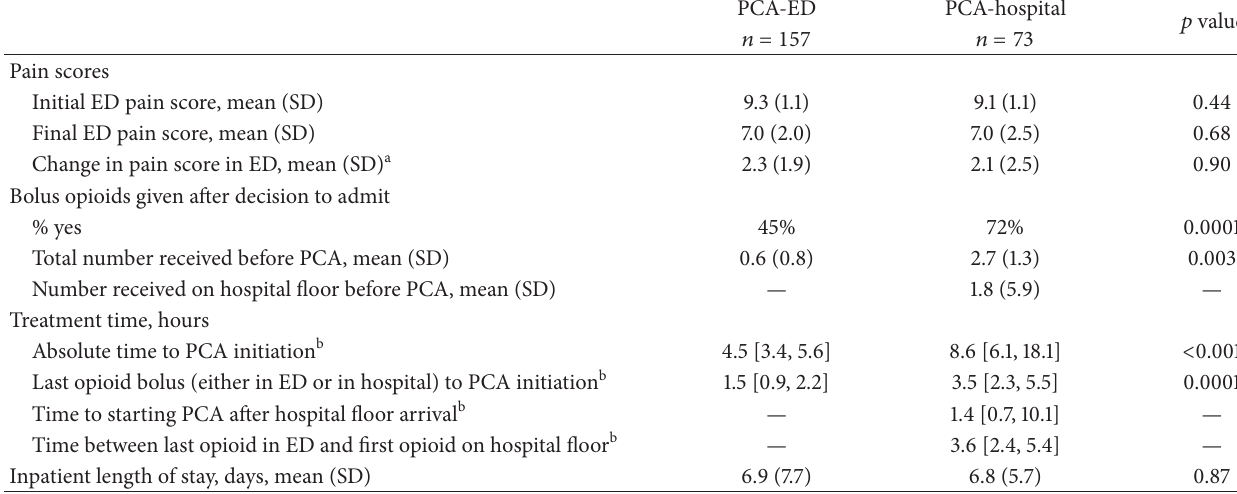
Table 2: Visit characteristics by PCA initiation location.